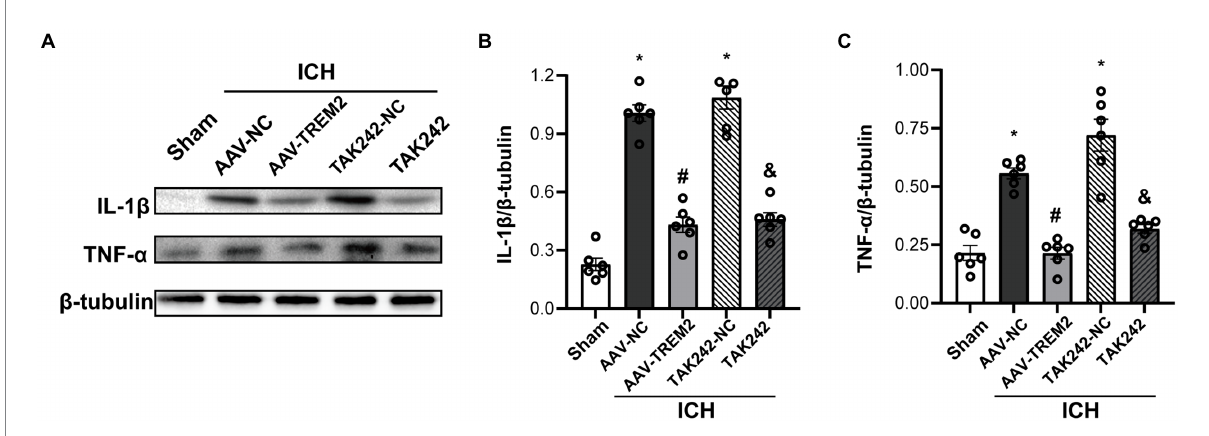
FIGURE 2 TREM2 overexpression alleviated intracerebral hemorrhage-induced neuroinflammation in the C57/BL6 mice. (A–C) The protein levels of IL-1 β and TNF- α in the C57/BL6 mice. * p < 0.05, vs. the sham group, # p < 0.05, vs. the AAV-NC + ICH group, & p < 0.05, vs. the TAK242-NC + ICH group. ICH: intracerebral hemorrhage, AAV, Adeno-associated virus, LV, lentivirus; NC, negative controls. The data were represented as mean ± SEM. n = 6 per